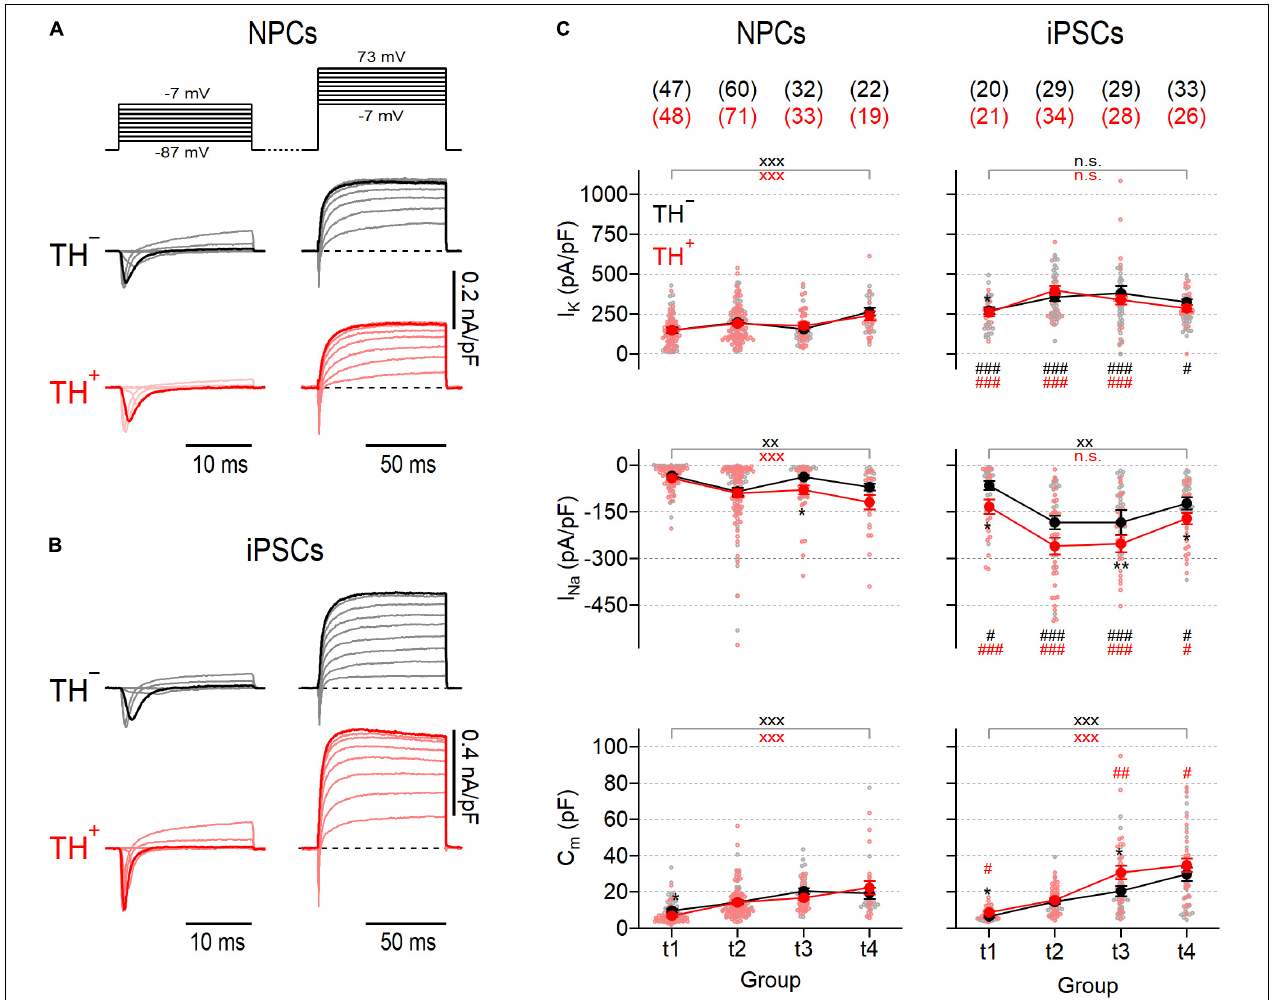
FIGURE 2 | Activity of voltage-gated Na V and K V channels in NPC- and iPSC-derived dopaminergic reporter lines. Families of representative current traces obtained from NPC-derived (A) or iPSC-derived (B) neurons either positive (TH + , red) or negative (TH − , black) for the expression of TH in response to various step depolarizations ( top, A ). 20-ms depolarizations ranging from –87 to –7 mV ( left ) were applied to elicit mostly Na V -specific fast activating and inactivating inward currents, whereas slow activating outward currents reflecting the activity of K V channels were triggered with 80-ms depolarizations ranging from to –7 mV to 73 mV ( right ). Inward and outward current traces highlighted in bold correspond to test pulse voltages to –27 mV and 73 mV, respectively. Data in (A,B) were obtained at time point 2 (t2), i.e., 3–4 weeks after neuronal differentiation was initiated. (C) Mean peak current densities associated to K V ( top ) or Na V ( middle ) channels and mean cell membrane capacitances ( bottom ), obtained from current traces at 73 mV and –27 mV, respectively, as shown in (A,B) at the indicated time points (t1–4). Individual data points are shown as open circles, filled circles represent means ± s.e.m. with the number of experimental replicates, n , indicated in parentheses. Straight lines connect means for clarity. Significance between pairs of data was tested with a two-tailed Mann–Whitney U -test: ** P < 0.01, * P < 0.05 for testing TH − against TH + neurons from the same line; xxx P < 0.01, xx P < 0.01 for testing data obtained at t1 against data obtained at t4; ### P < 0.001, ## P < 0.01, # P < 0.05 for testing data obtained from NPCs against data obtained from iPSCs; n.s., not